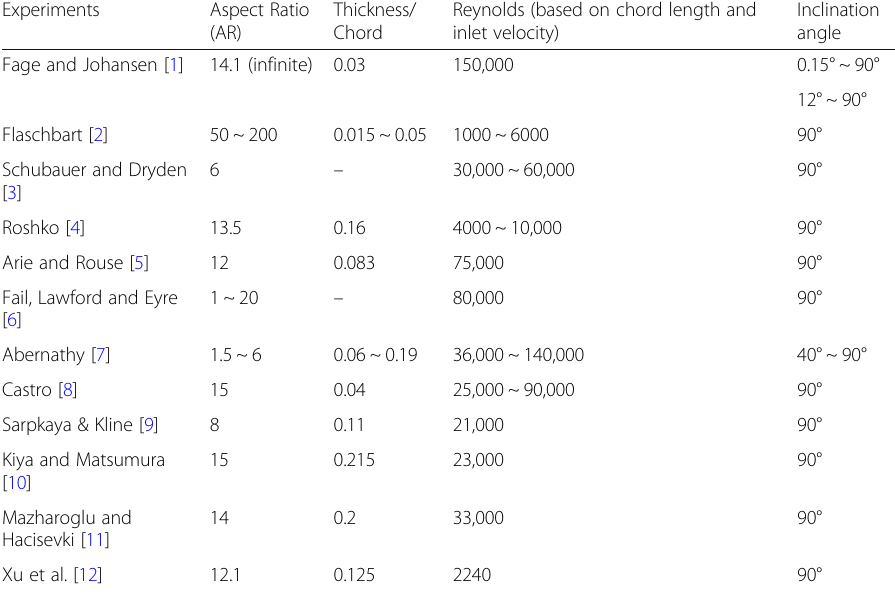
Table 1 A summary of previous experimental studies on flow over inclined flat plate Experiments Aspect Ratio Thickness/ Reynolds (based on chord length and (AR) Chord inlet